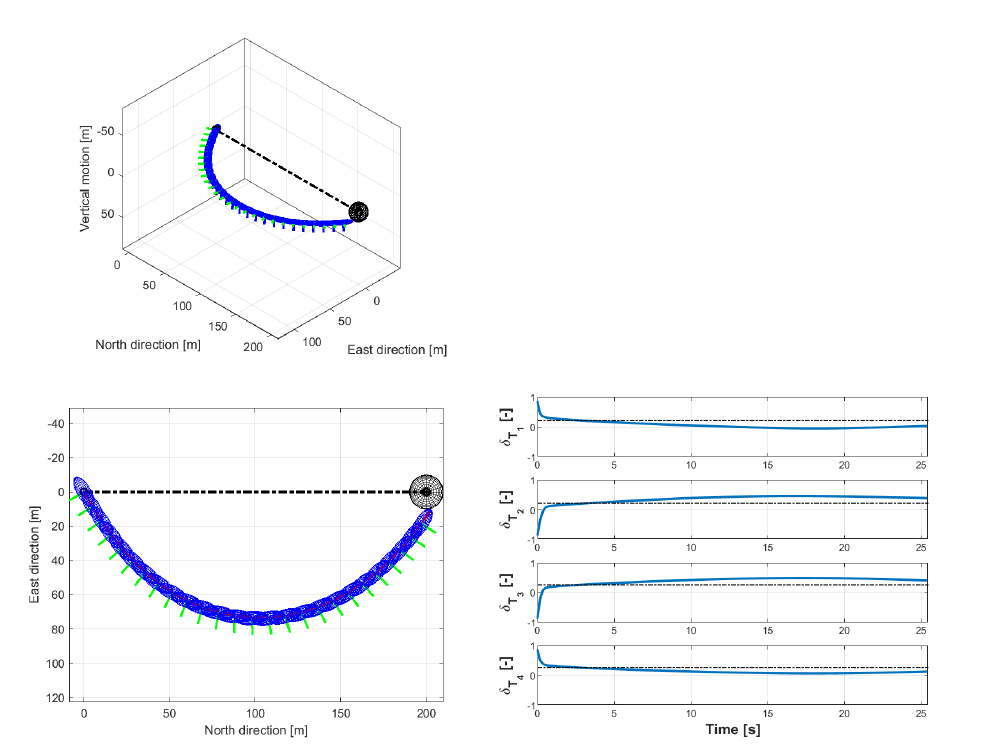
Figure 14. Trajectory and control behavior for an initial misalignment ∆ ψ 0 = 60 degree with respect to a horizontal track, as flown by the four-thrusters stabilized airship, with the thrust-based guidance control system, at 10 m/s of ground speed. ( Top-left ) three-quarter view of the 3D trajectory from the northeast. ( Bottom-left ) view of the trajectory from the top. Black dash-dotted lines: target track. Black spheres: target checkpoint capture volume. ( Bottom-right ) time histories of controls. Black dash-dotted lines: trimmed